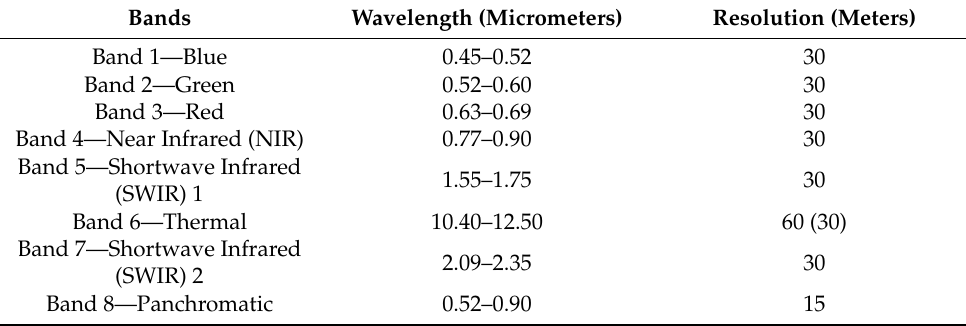
Table 2. Landsat 7 Enhanced Thematic Mapper Plus (ETM+).